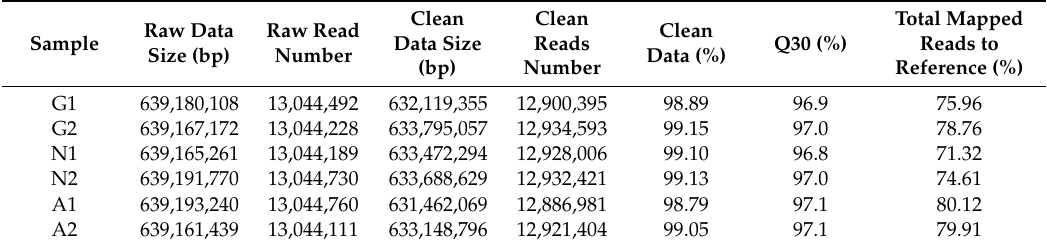
Table 3. Quality and alignment metrics of the RNAseq data of CLso infected and uninfected B. trigonica